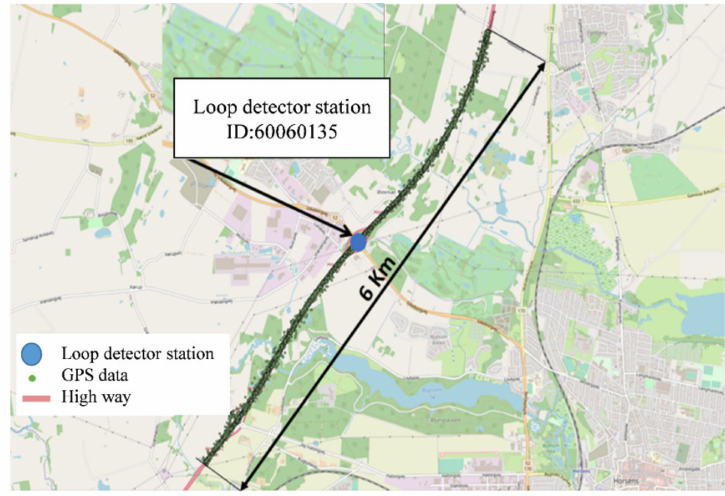
Figure 9. Location of loop detector and the GPS